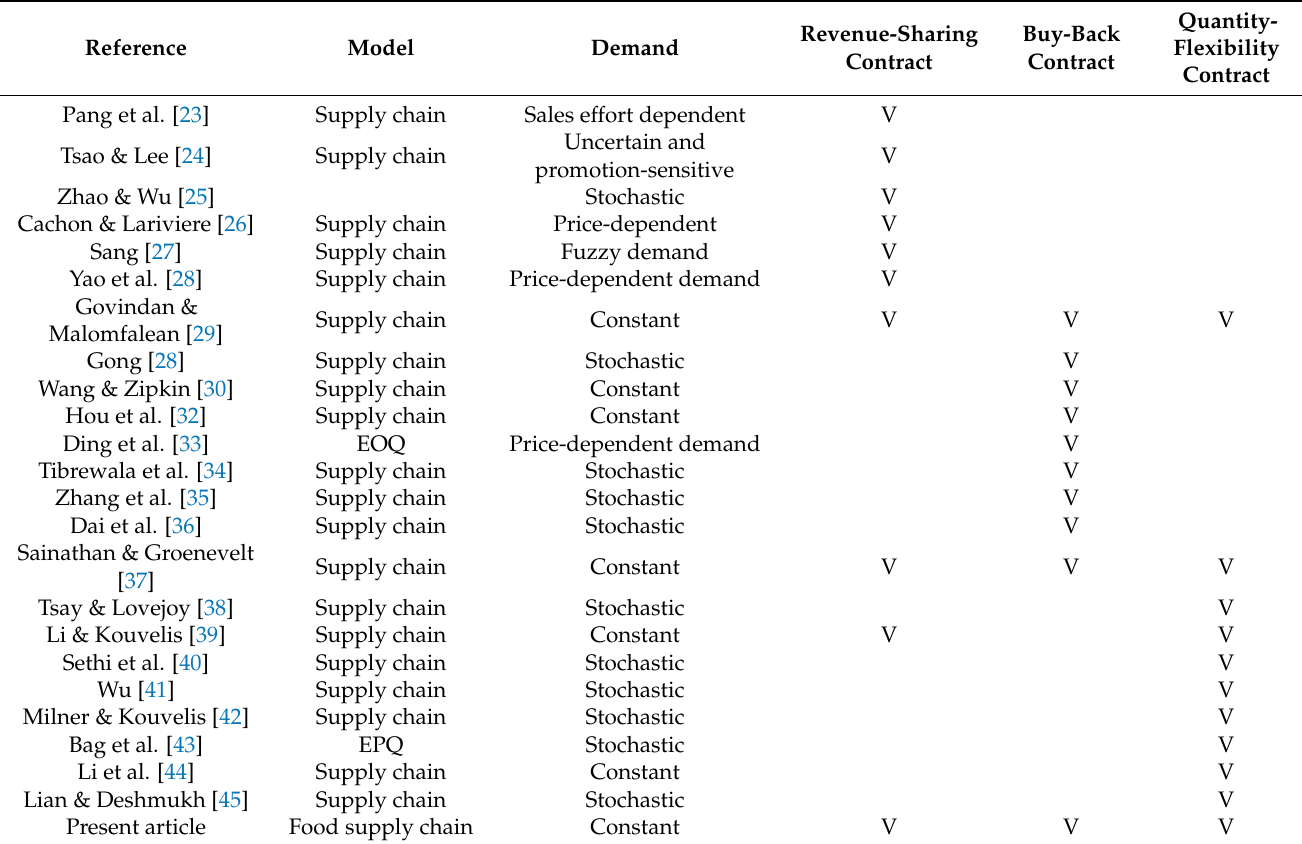
Table 1. The main classification of inventory models from relevant studies.